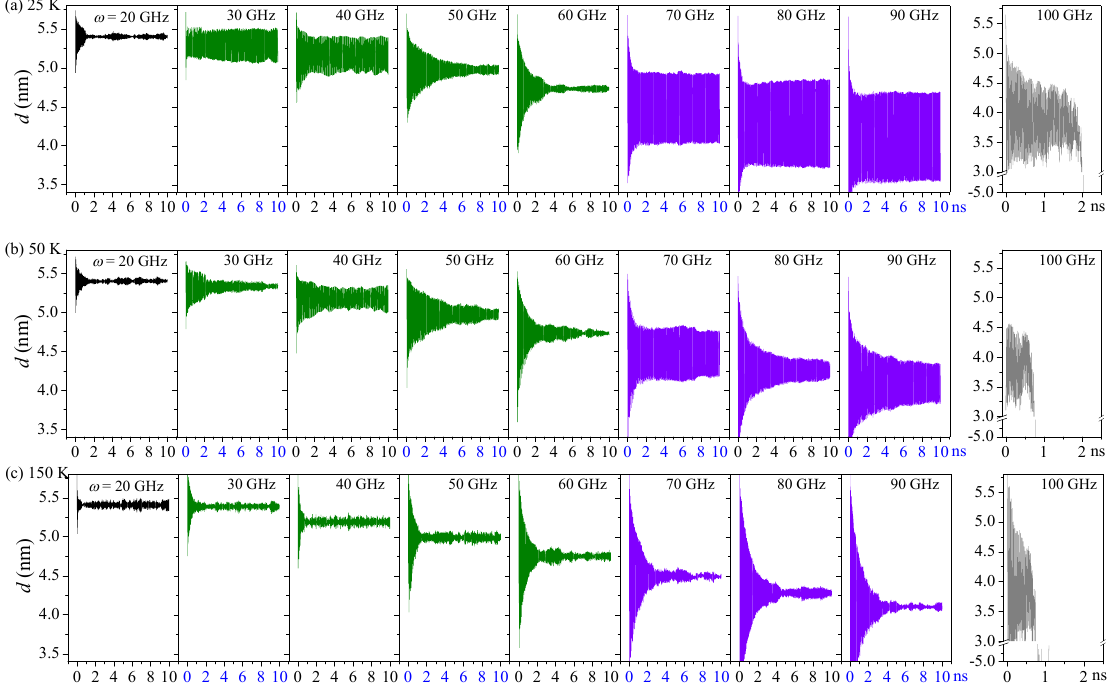
Figure 4. Axial motion of the R-rotor in the Z2H6 system with different inputs at temperatures higher than 8 K: ( a ) at 25 K, ( b ) at 50 K, and ( c ) at 150 K.